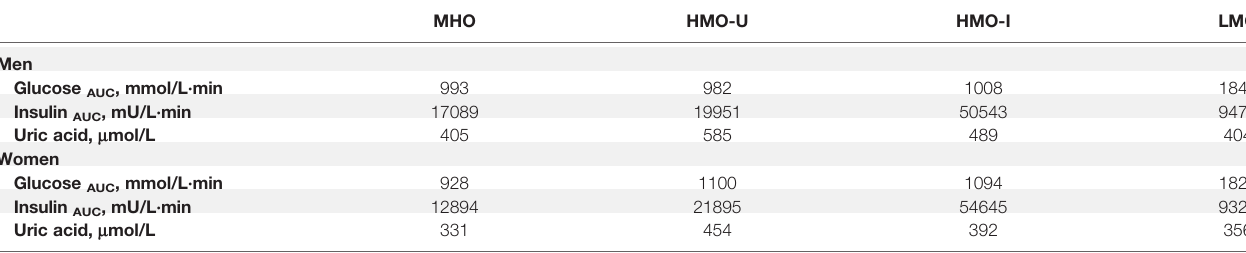
TABLE 2 | Cluster centers in Cohort-1 with k-means